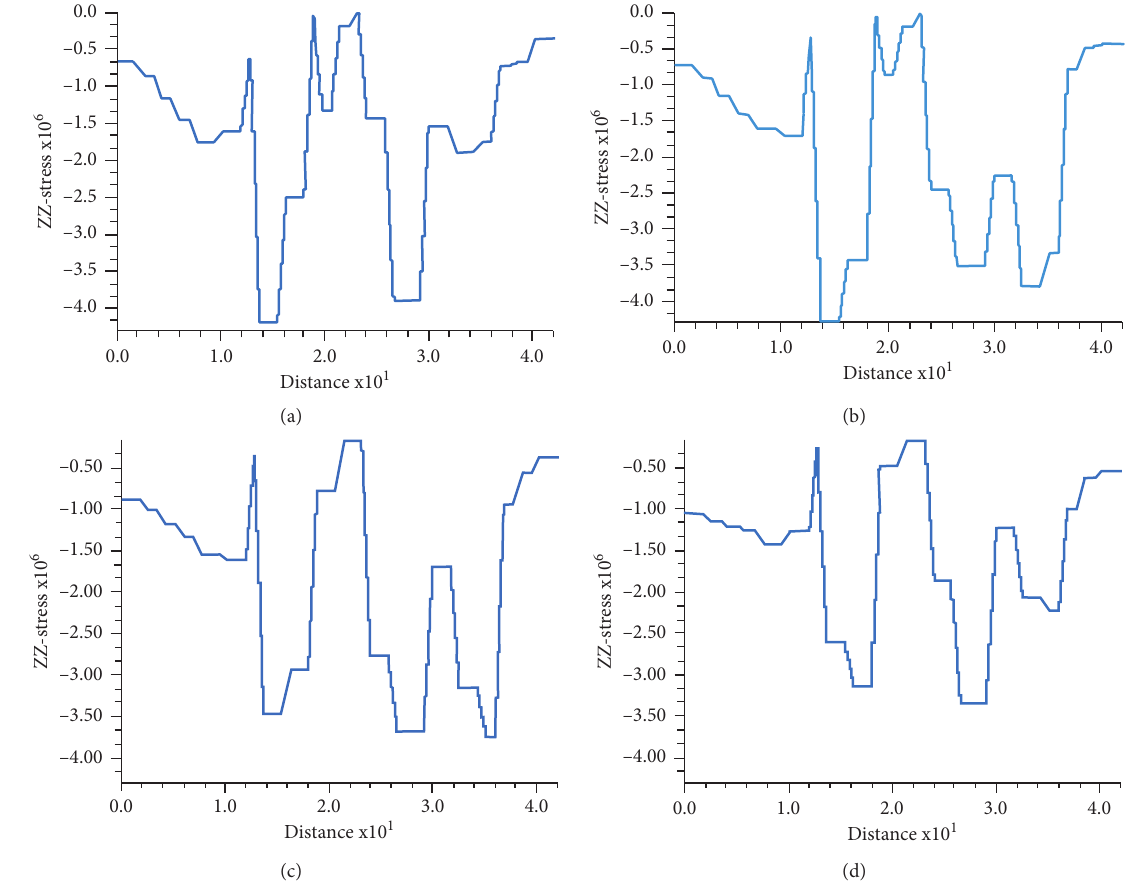
Figure 6: The stress distribution above the surrounding rock at different locations under the original support system. (a) Stress distribution above the tunnel 0m from (45 0 52.7) to (87 0 52.7). (b) Stress distribution above the tunnel 10m from (45 0 52.7) to (87 0 52.7). (c) Stress distribution above the tunnel 20m from (45 0 52.7) to (87 0 52.7). (d) Stress distribution above the tunnel 30m from (45 0 52.7) to (87 0 52.7). Table 4: X-ray diffraction analysis of all rock minerals. Sample